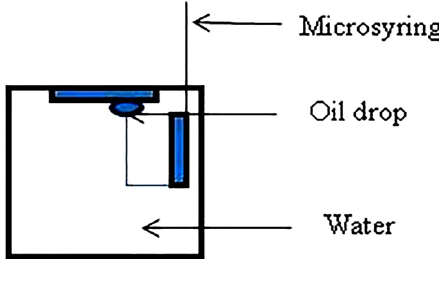
Figure 1. Experimental set up for the measurement of the oil drop contact angle under